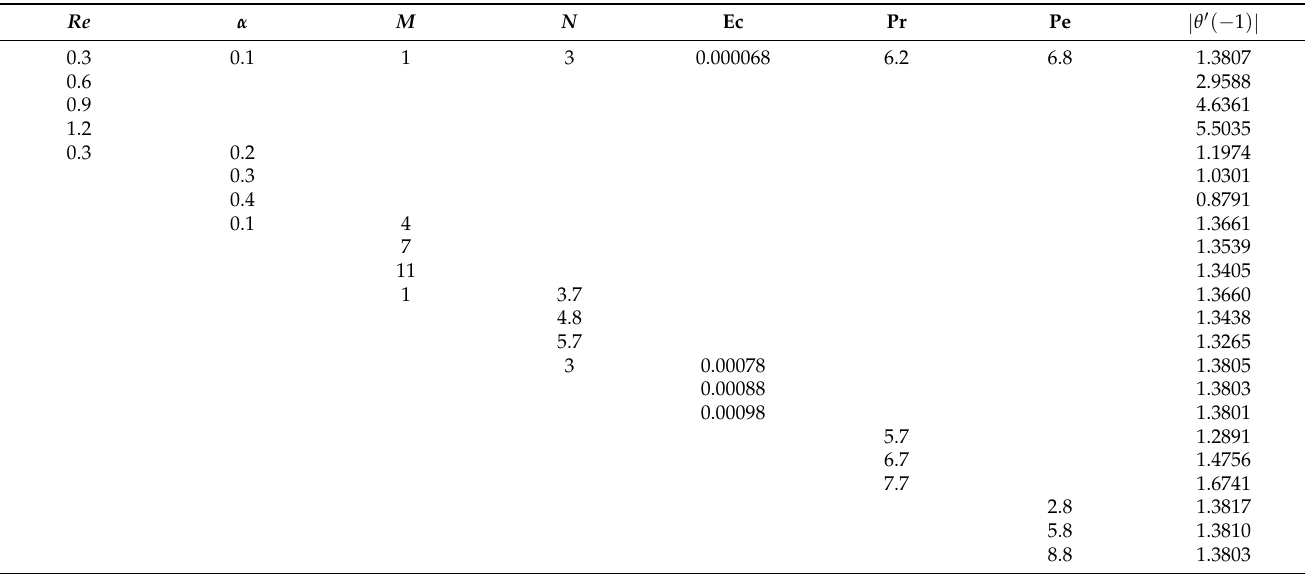
Table 6. The effect of different physical nondimensional parameters Re , α (wall expansion), M (magneitc parameter), N (shape factor), Ec (Eckert number), Pr (Prandtl number), Pe (Peclet number) θ (temperature) on heat transfer.